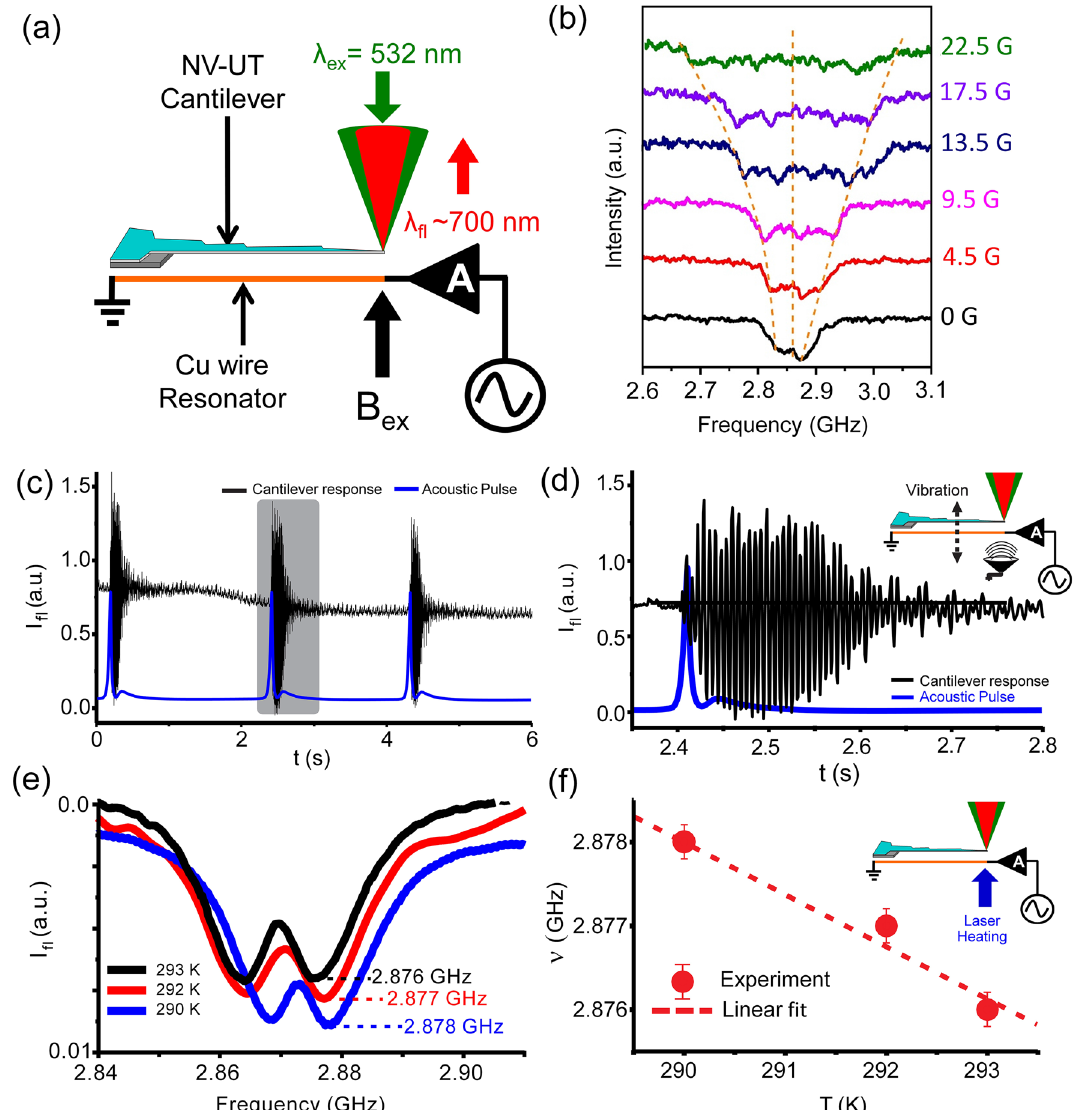
ex = 0, 4.5, 9.5, 13.5, 17.5, and 22.5 G. The broadening of spectra is caused by a gradual increase in